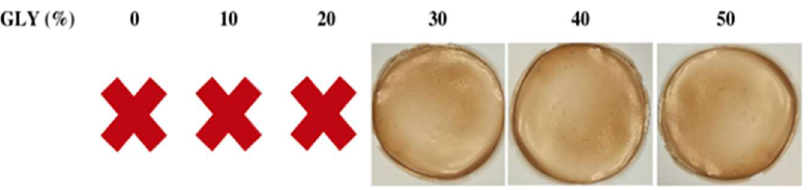
Figure 3. Films obtained at pH 12 using 600 mg argan seed protein concentrate in the presence of different concentrations of glycerol (GLY). No manipulable films (X).